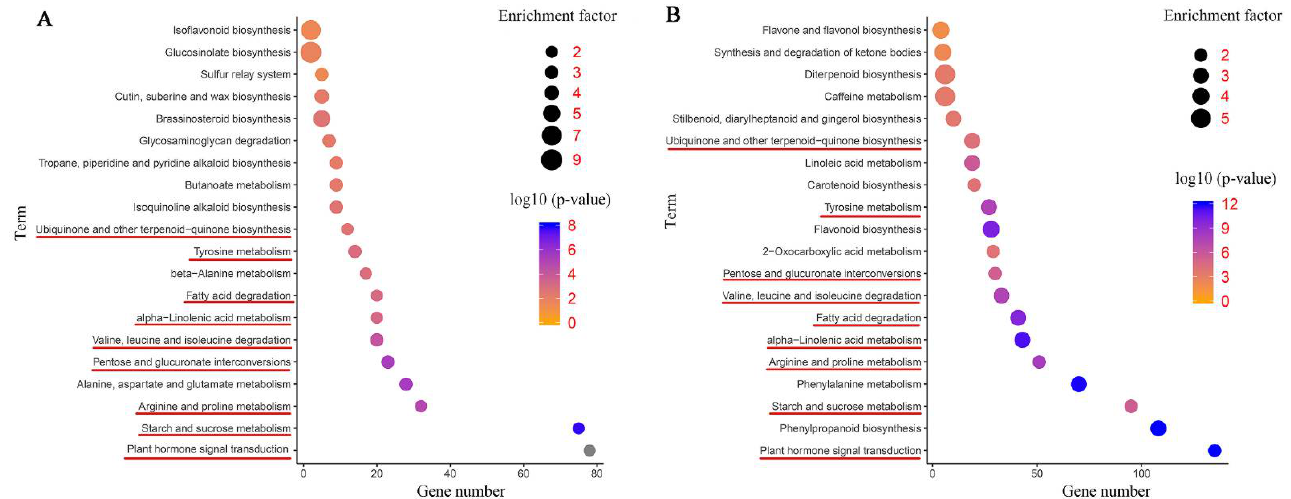
Figure 6. Kyoto Encyclopedia of Genes and Genomes (KEGG) pathway enrichment scatter diagram of DEGs. Only the top 20 most strongly represented pathways are displayed in the diagram. The degree of KEGG pathway enrichment is represented by an enrichment factor, the FDR value, and the number of genes enriched in a KEGG pathway. The enrichment factor indicates the ratio of differentially expressed genes enriched in this pathway to the total number of annotated unigenes in this pathway. The red underline represents the same enriched pathways among whole plants, leaves, roots, and co-induced DEGs. ( A ) KEGG enrichment analysis of the leaves. ( B ) KEGG enrichment analysis of the roots.